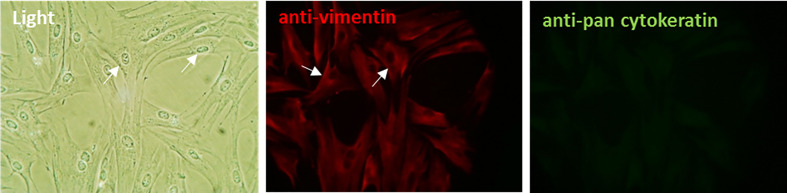
Characterization of primary bovine foot skin fibroblast cells. Primary fibroblast cells demonstrated prominent cytoplasmic projections (arrows) and the elongated spindle-shaped morphology which is typical of fibroblasts in culture. Following initial subculture, cells demonstrated positive immunofluorescence labeling for the key intermediate filament protein of fibroblasts, vimentin (anti-vimentin; red) and negative labeling for several acidic (56.5/50/48/40 kDa) and basic (65–67/64/59/58/56/52 kDa) cytokeratins (anti-pan cytokeratin; green), which are intermediate filament proteins typically expressed by epidermal keratinocytes. Data representative of three independent experimental replicates. Scale, ×20 magnification.